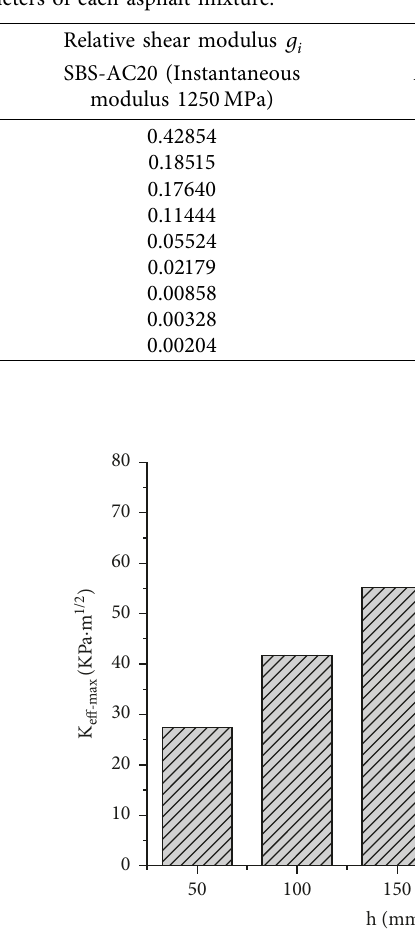
Figure 3: Keff-max of single nonpenetrating crack time history curve with various